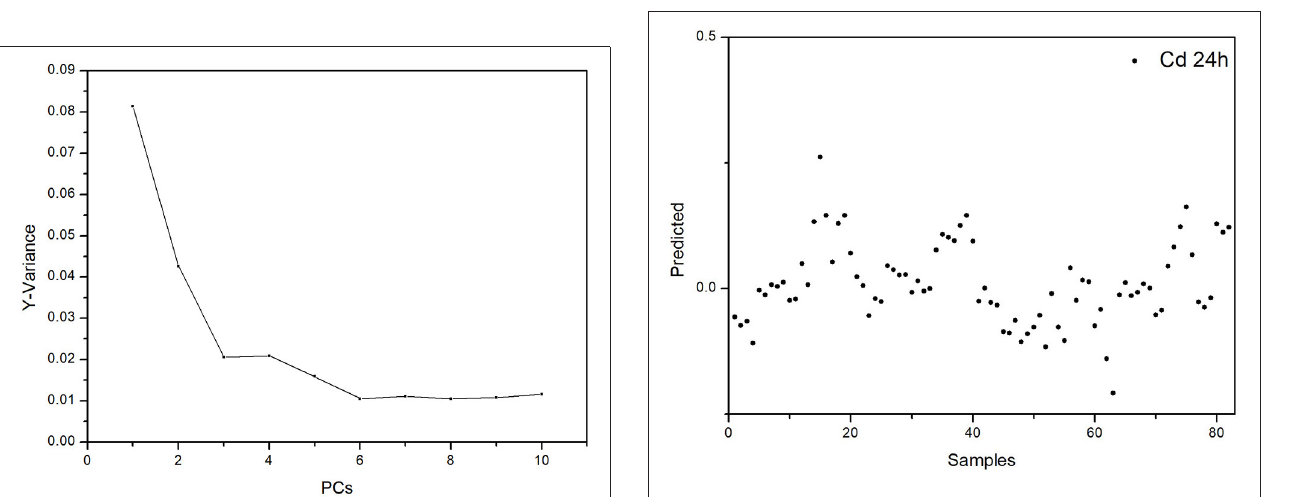
FIGURE 8 | Discrimination of the rats with acute cadmium poisoning using the proposed PLS-DA model for ALP.